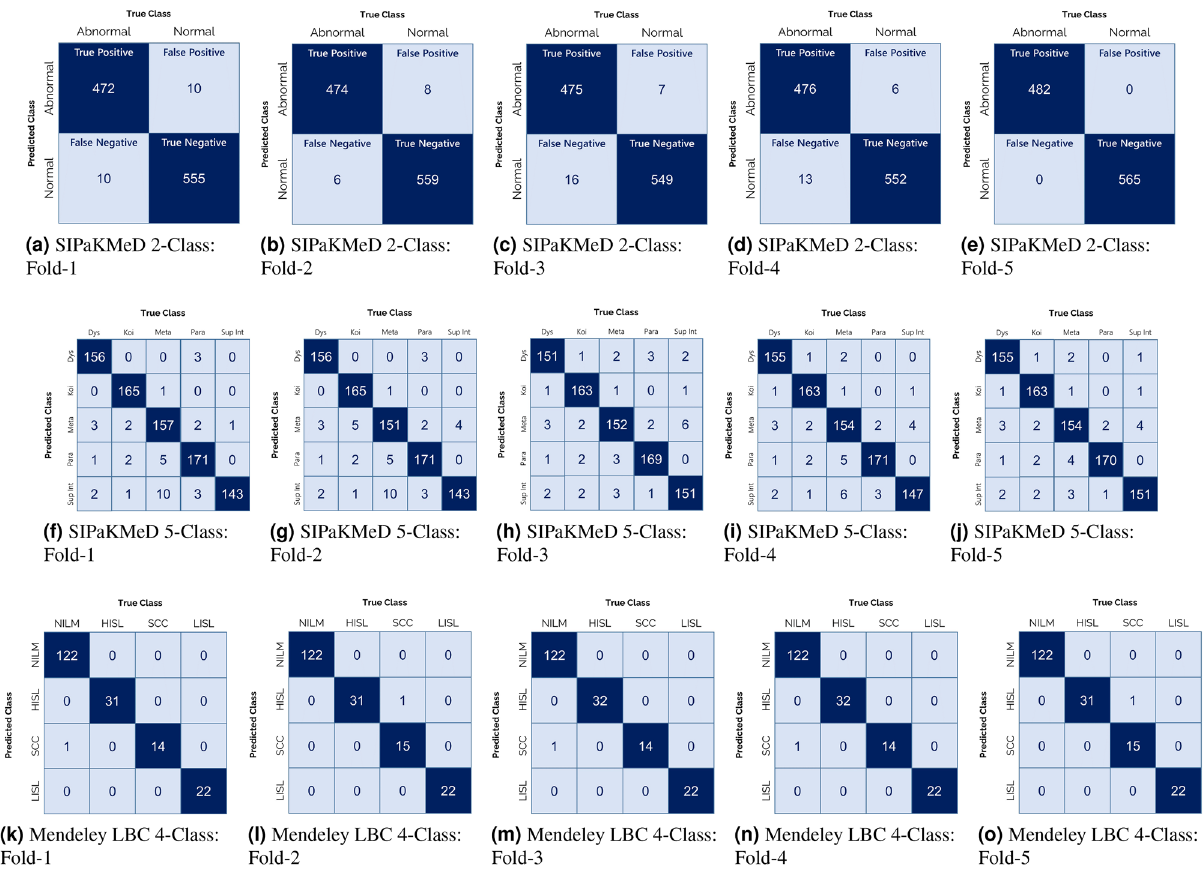
Figure 11. Confusion matrices obtained by the proposed method on the three datasets used in this research on fivefold cross-validation. Dys dyskeratotic, Koi koilocytotic, Meta metaplastic, Para parabasal, SupInt superficiel intermediate. NILM negative for intra-epithelial malignancy, HSIL high squamous intra-epithelial lesion, SCC squamous cell carcinoma, LSIL low squamous intra-epithelial lesion (images have been made by R.K. using Google Slides).